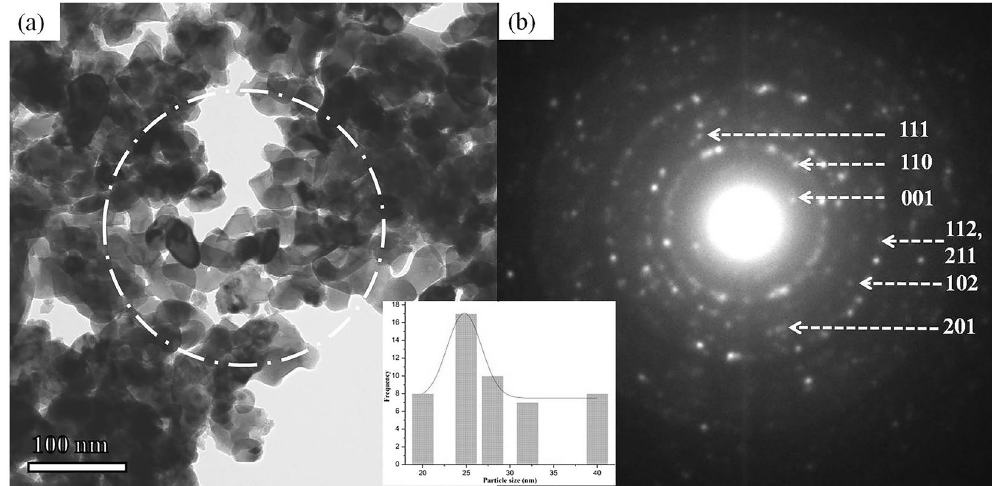
Figure 1. ( a ) Low magnification TEM image of as-prepared PTO sample, ( b ) Corresponding SAED pattern of circled area. The inset is a size distribution curve of the